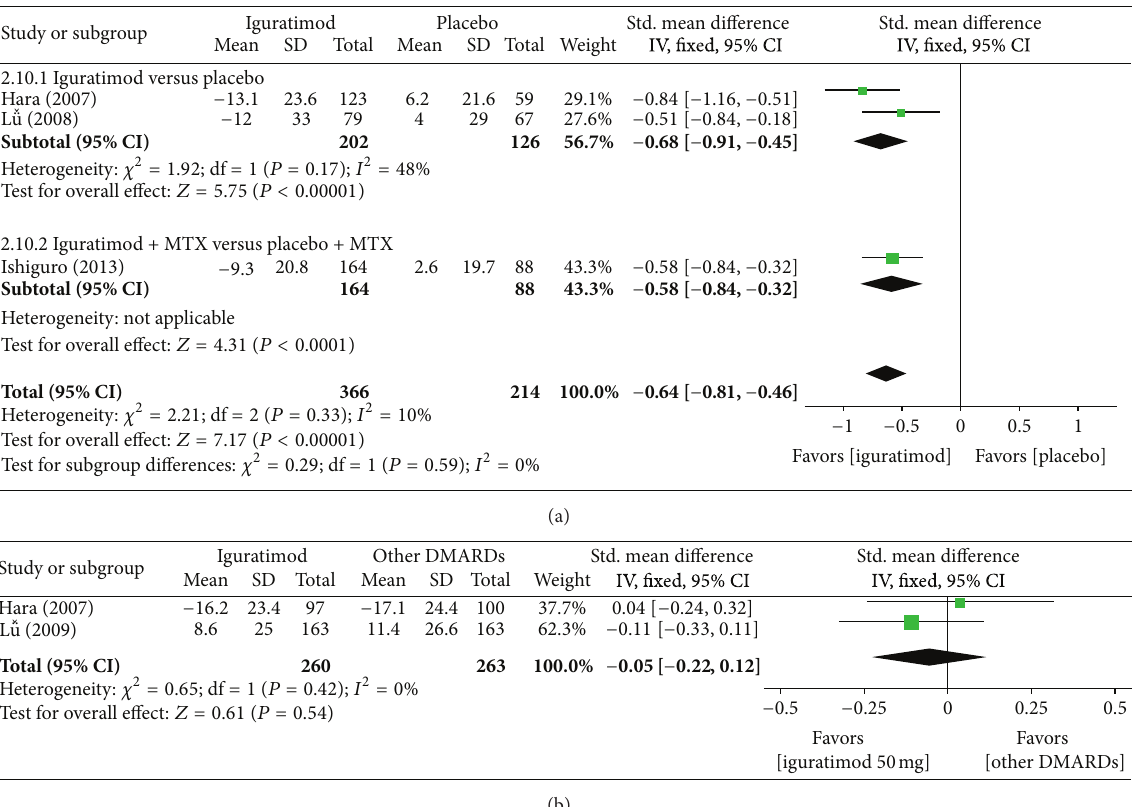
Figure 12: (a) Comparison of ESR score between iguratimod and placebo groups. (b) Comparison of ESR score between iguratimod and other DMARDs (MTX and SASP)